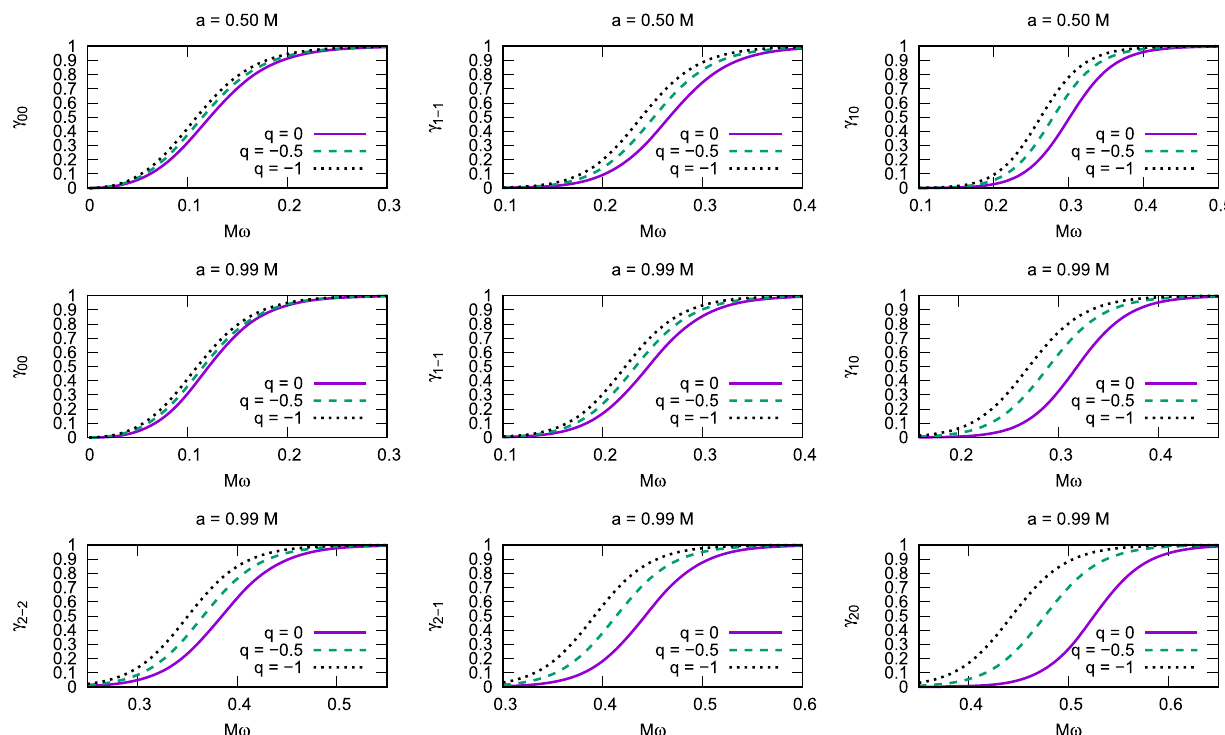
Fig. 9 Greybody factors describing the scattering of massless scalar waves by rotating black holes with tidal charge computed numerically for a / M = 0 . 50 , 0 . 99, q = 0 , − 0 . 5 , − 1, and l = 0 , 1 , 2